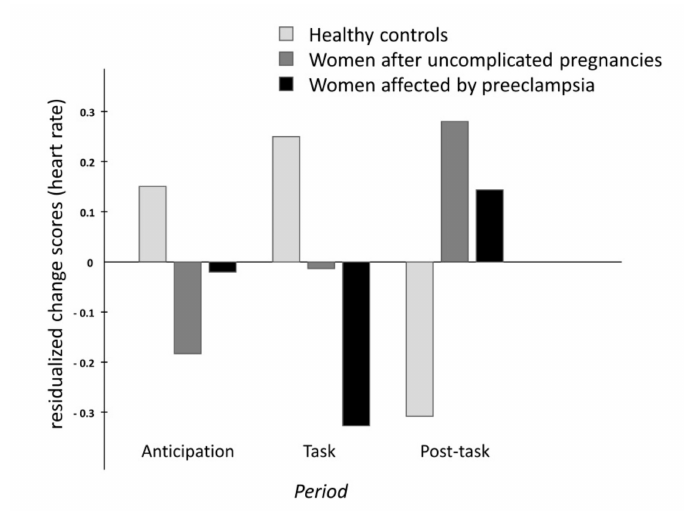
Figure 1. Barplot of the standardized residualized change scores for heart rate (HR).